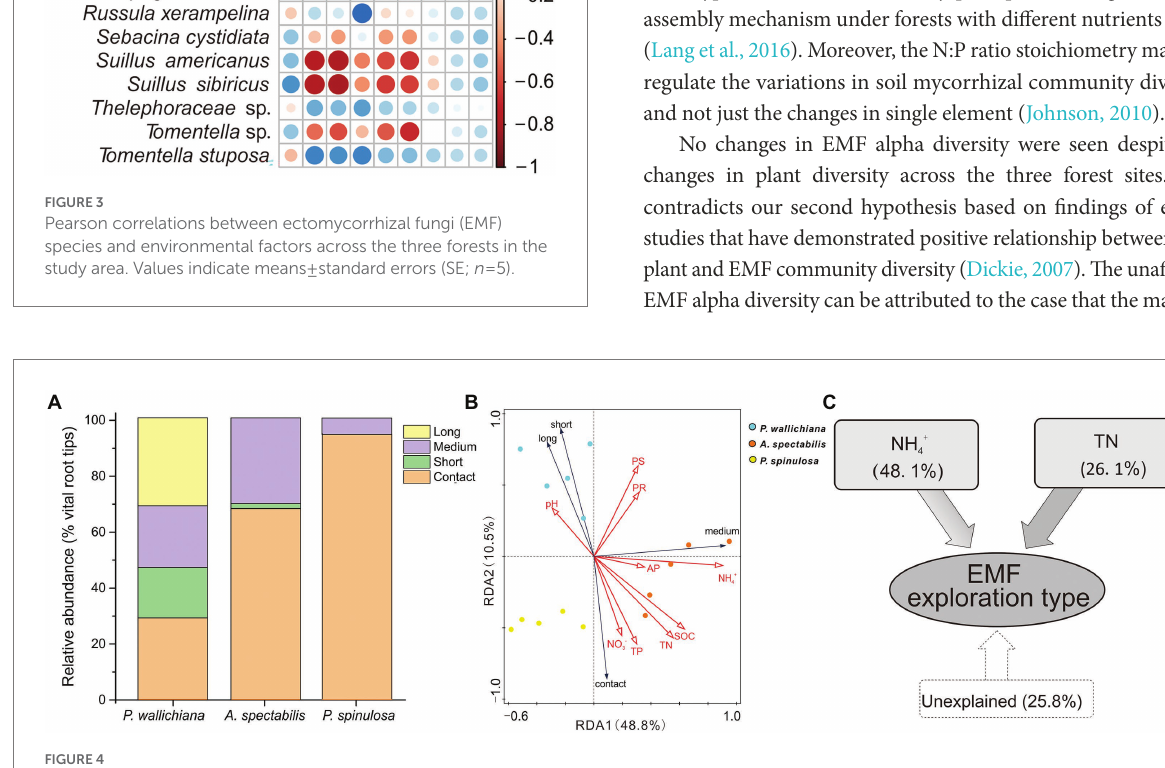
FIGURE 4 Exploration types mode-based community structure (A) , redundancy analysis (B) and variation partition analysis (C) of ectomycorrhizal (EMF) species across the three forests ( Pinus wallichiana , Abies spectabilis , and Picea spinulosa ). TN, total nitrogen; NH 4+ , ammonia